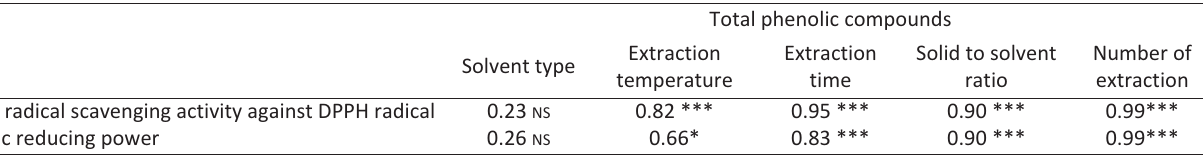
NS = Not significant. * = Significant at p<0.05. *** = Significant at